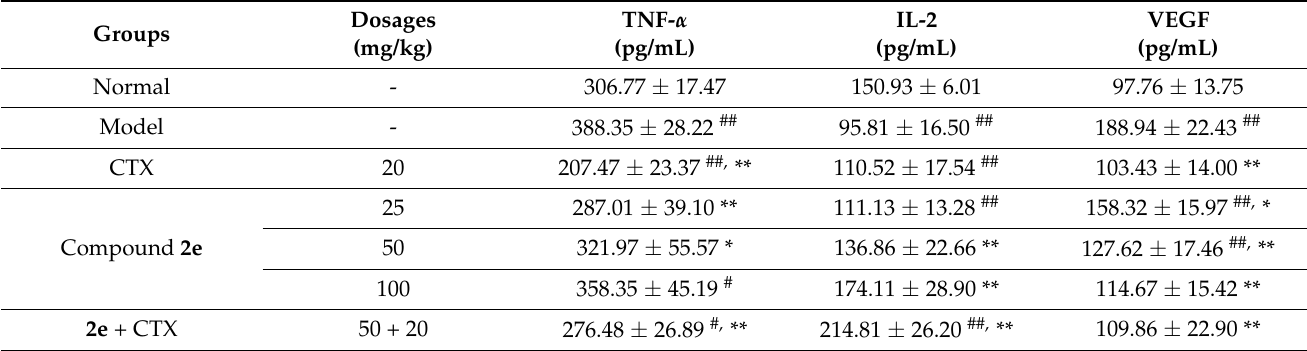
Table 3. Effects of compound 2e on cytokine levels (mean ± SD, n = 6) in H22 tumor-bearing mice.